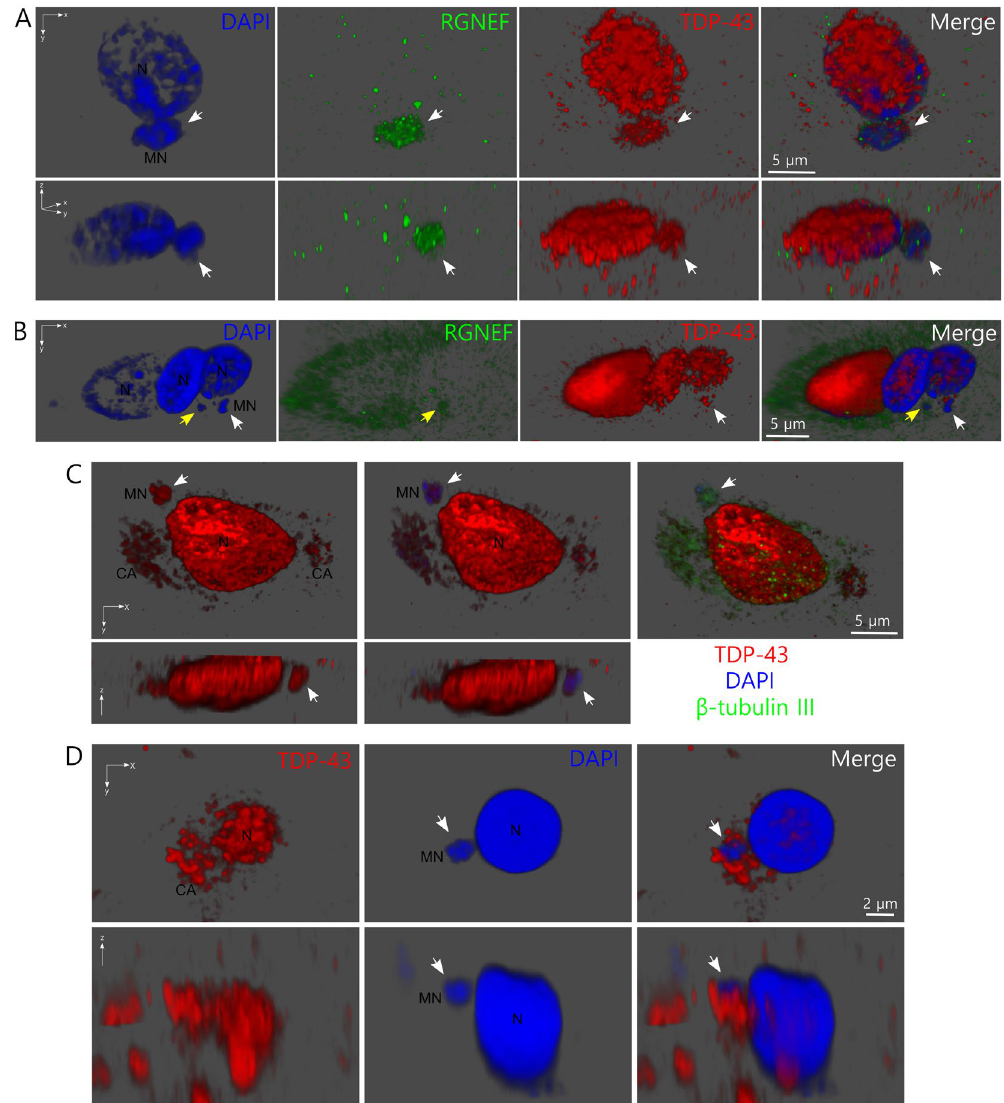
Figure 6. Micronucleus-like structures are observed in tissue from ALS patients. ( A ) 3D reconstruction from confocal set of images of a cell showing a micronucleus-like structure (white arrow) in hippocampus from ALS patient number 1. The upper panels show xy axis plane for DAPI staining, RGNEF, and TDP-43 detection. The lower panels show the lateral z axis planes of the images. Note that the micronucleus-like structure is positive for RGNEF, TDP-43 and nucleic acids. ( B ) 3D reconstruction from confocal set of images of a cell showing micronucleus-like structure (white arrow) in hippocampus from ALS patient number 2. The panels show xy axis plane for DAPI staining, RGNEF, and TDP-43 detection. The white arrow indicates a micronucleus-like structure positive for TDP-43 and nucleic acids. The yellow arrow indicates a micronucleus-like structure positive for RGNEF and nucleic acids. ( C) 3D reconstruction from confocal set of images of a cell showing micronucleus-like structure (white arrow) in hippocampus from ALS patient number 3. The upper left panel shows xy axis plane for TDP-43 detection, the middle upper panel shows also DAPI staining and the upper right panel shows additionally the detection of β -tubulin III. The lower panels show the z axis planes for the TDP-43 detection and TDP-43 plus DAPI detection. ( D ) 3D reconstruction from confocal set of images of a cell showing micronucleus-like structure (white arrow) in cervical spinal cord from ALS patient number 3. TDP-43 and nucleic acids (using DAPI) were detected. Upper and lower panels show xy and z planes of the cell, respectively. Abbreviations: MN = micronucleus-like structure; N = cell nucleus; CA = TDP-43 cytoplasmic